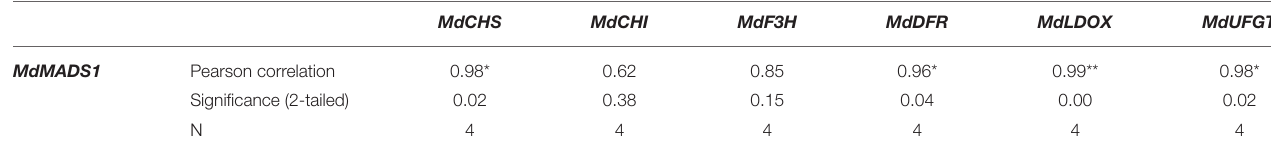
* Correlation is significant at the 0.05 level (2-tailed). ** Correlation is significant at the 0.01 level (2-tailed).